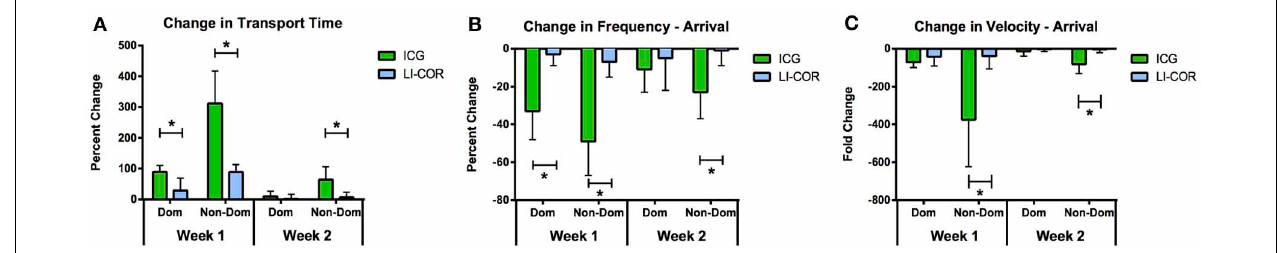
FIGURE 8 | LI-COR IRDye 800CW PEG reduces lymphatic function less than ICG. Percent change in (A) transport time, (B) packet frequency, and (C) packet velocity between initial